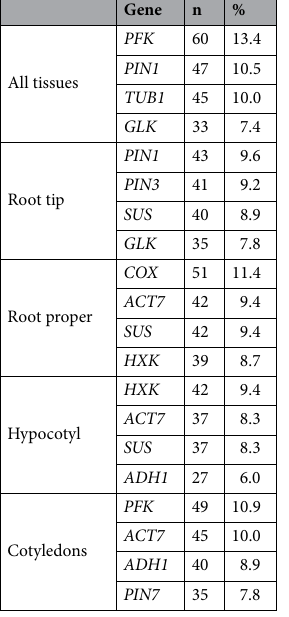
Table 3. Assessment of the consistency of transcription data based on the average of examined tissues. The top four choices of all combinations (as in Sup. Table 2) are based on the percentage that resulted in the least scatter of all 448 combinations (16 genes by 28